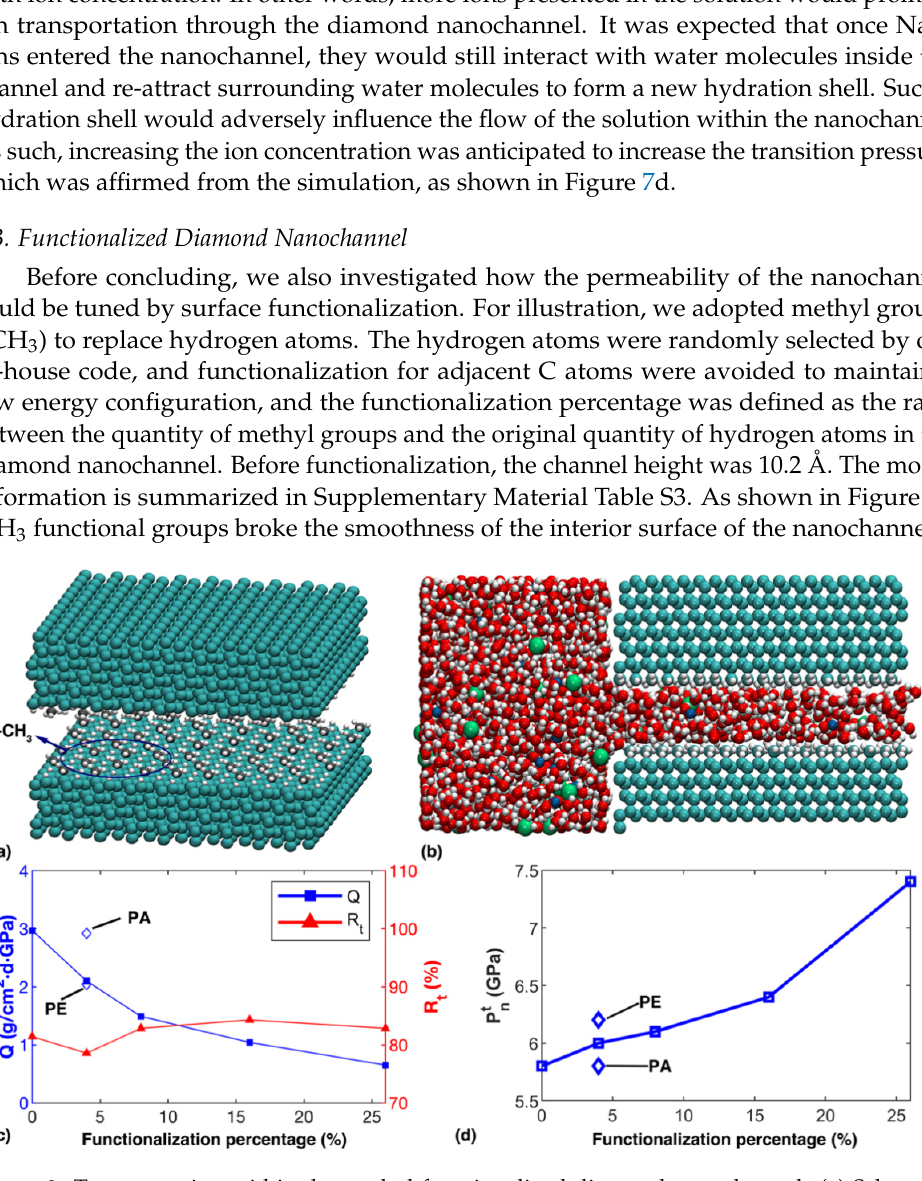
Figure 8. Transportation within the methyl-functionalized diamond nanochannel. ( a ) Schematic view of the methyl-functionalized diamond nanochannel; ( b ) Snapshot of solution transport within the nanochannel with 26% surface functionalization; ( c ) The water flux and ion retention rate as a function of the functionalization percentage; and ( d ) The transition nominal pressure as a function of the functionalization percentage. In ( c , d ), notation PA and PE represent the parallel and perpendicular alignment, respectively.